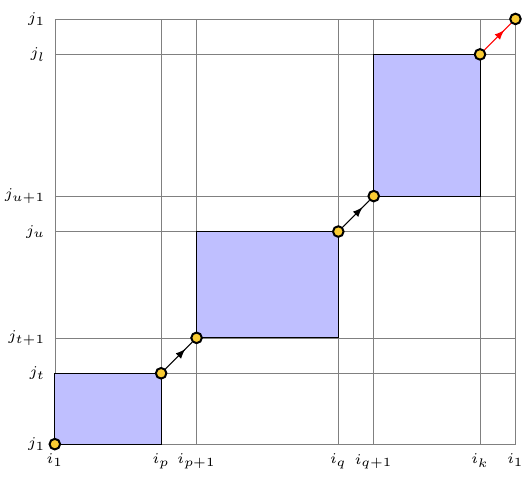
Figure 15. The general structure of a term in W PQ descending from an order k and an order l terms. The blue boxes contain paths involving horizontal and vertical fields, i.e. products of a field and a node. The multiplicity of terms corresponds to the different ways of choosing the two black diagonal